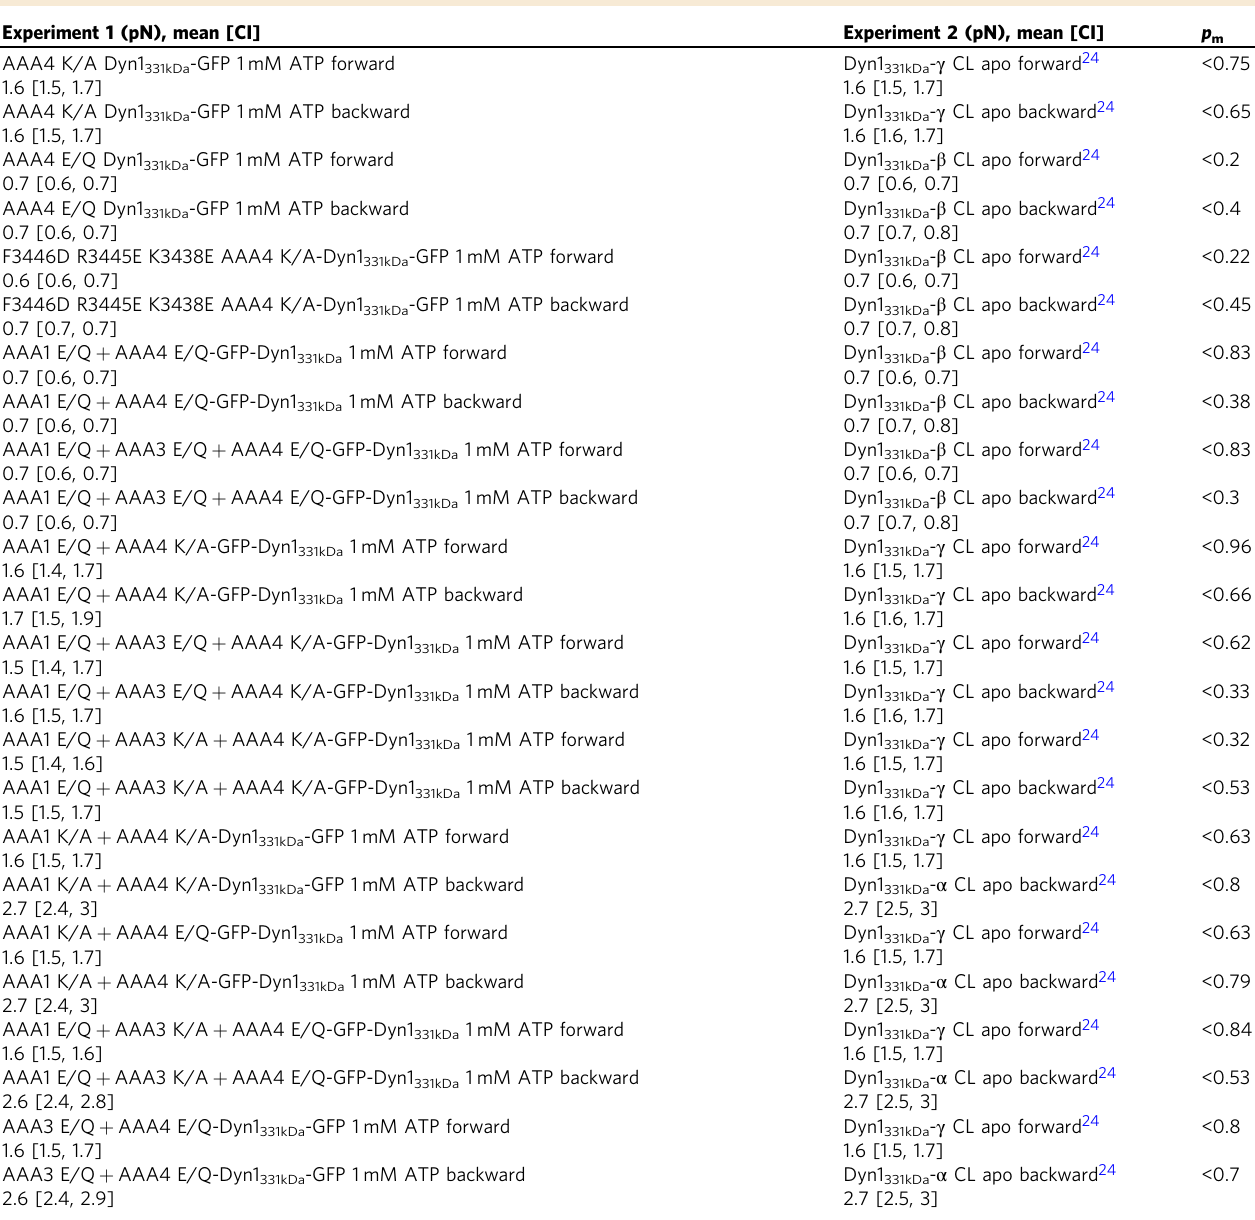
Table 2 Results of statistical comparisons for various measured unbinding force histograms. Experiment 1 (pN), mean